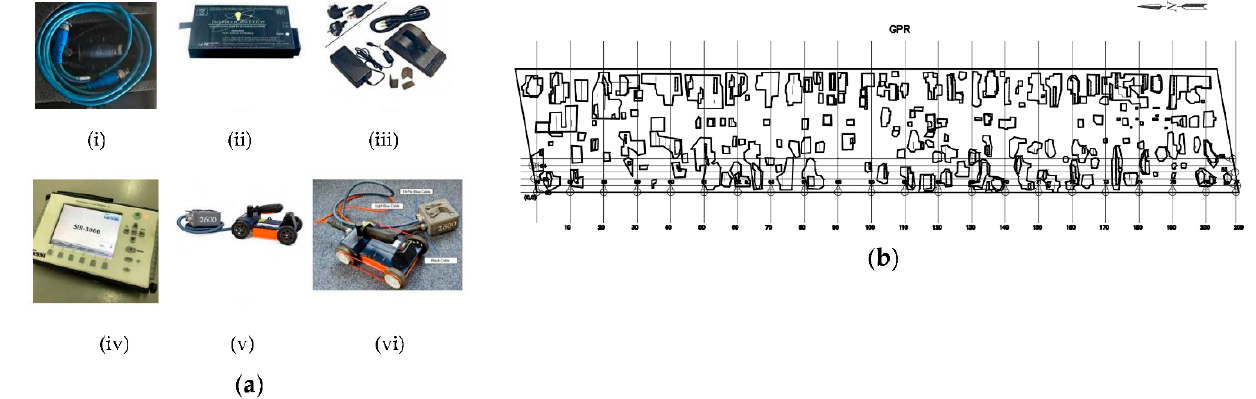
Figure 4. GPR data collection depicting ( a ( i ) – ( vi )) scan for GPR data collection ( b ) GPR scan lines. The GPR signals have a vertical time scale of 12 ns and 512 samples per scan. The longitudinal scans along the length of the bridges gave a maximum output file having 16,383 amplitudes. The transverse signals along the width of the bridges gave an output file having about 1225 amplitudes.